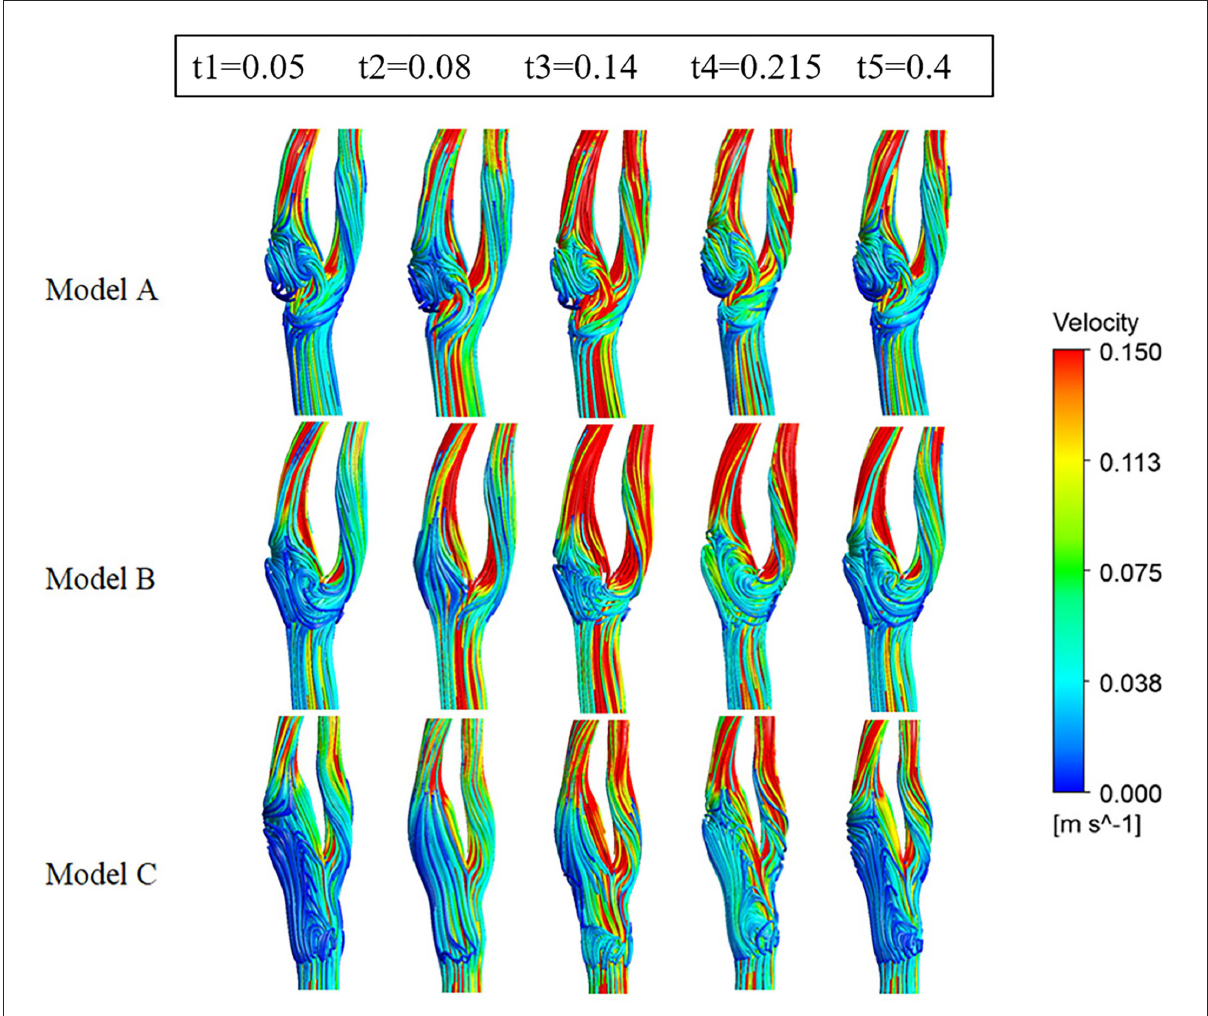
FIGURE4 Streamlines colored by the magnitude of velocity at five time